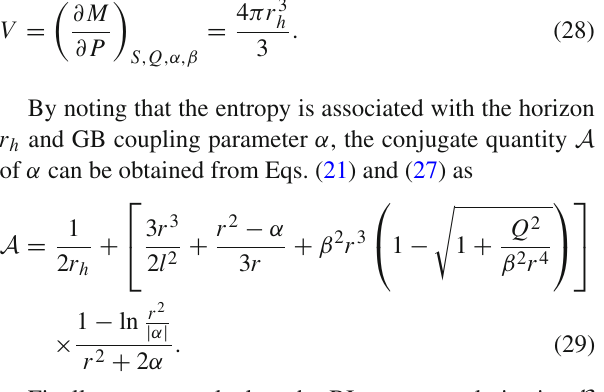
the black hole has a negative specific heat when the horizon radius is smaller than some critical size r s black holes are stable against fluctuations. A black hole with positive α has larger stable region than that with